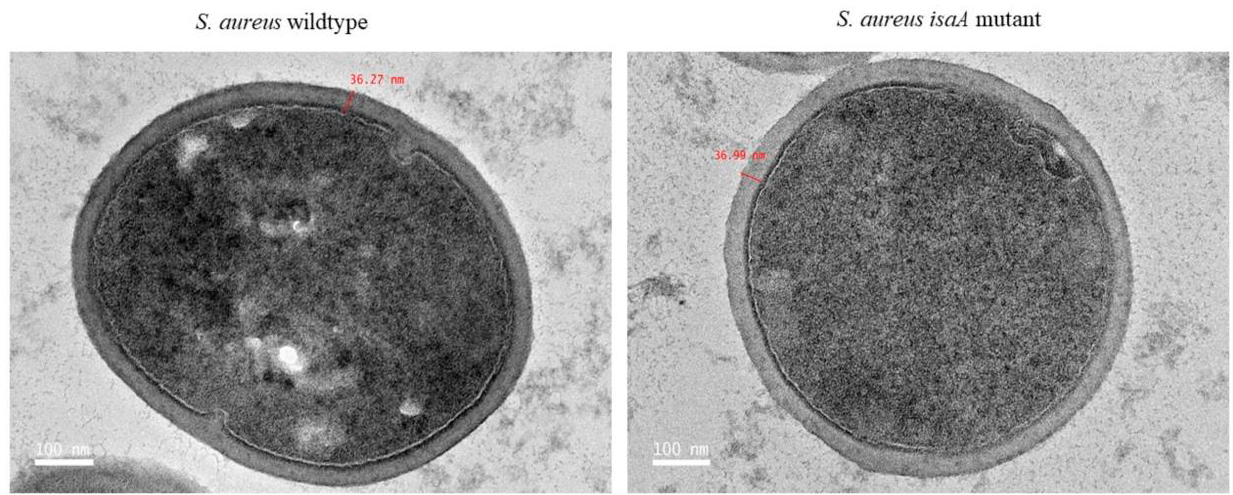
Figure 2. Transmission electron microscopy (TEM) images of Staphylococcus aureus . Both wildtype ( S. aureus SH1000) and isaA mutant ( S. aureus MS001) have intact cell walls. Scale bars: 100